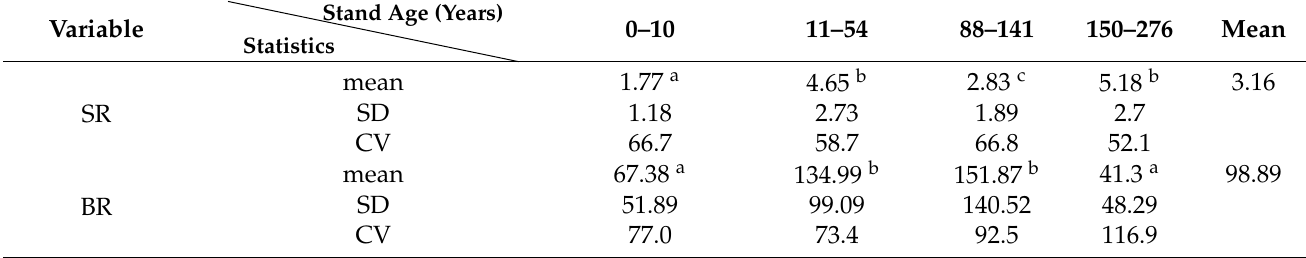
Table 2. Descriptive statistics of soil respiration (SR, µ mol m − 2 s − 1 ), soil temperature (ST5, ◦ C), soil water content